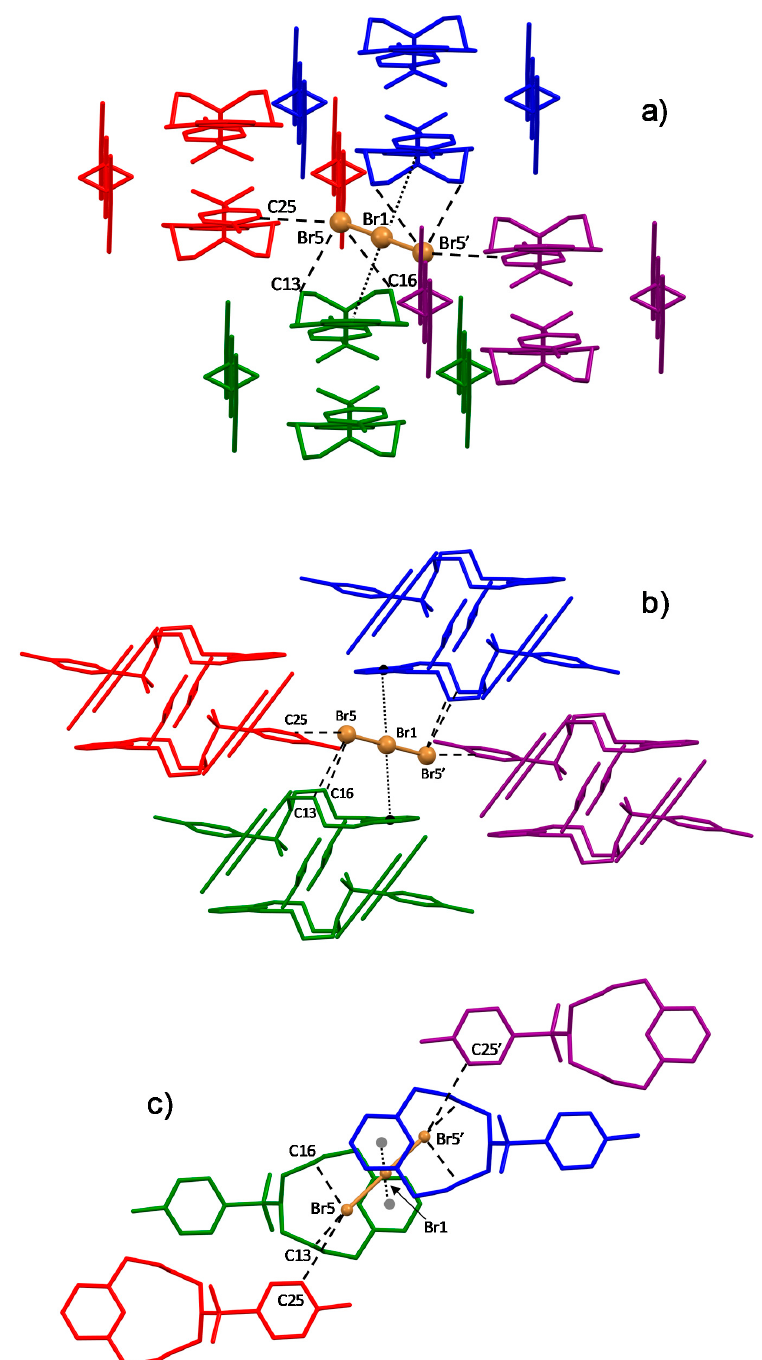
Figure 5. Lateral ( a ) and ( b ) and top ( c ) views of the Br 3 − anion sandwiched between pyridine ligand groups in the crystal structure of (H 2 L-Ts)(Br 3 ) 1.5 (NO 3 ) 0.5 .